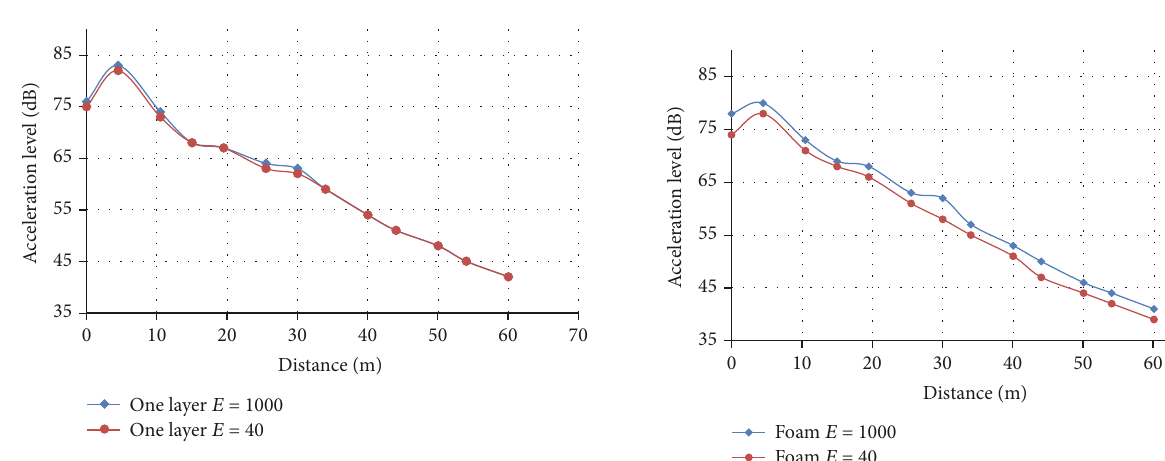
Figure 12: The comparison of acceleration between case 1 and case 6 in Scheme 1 .